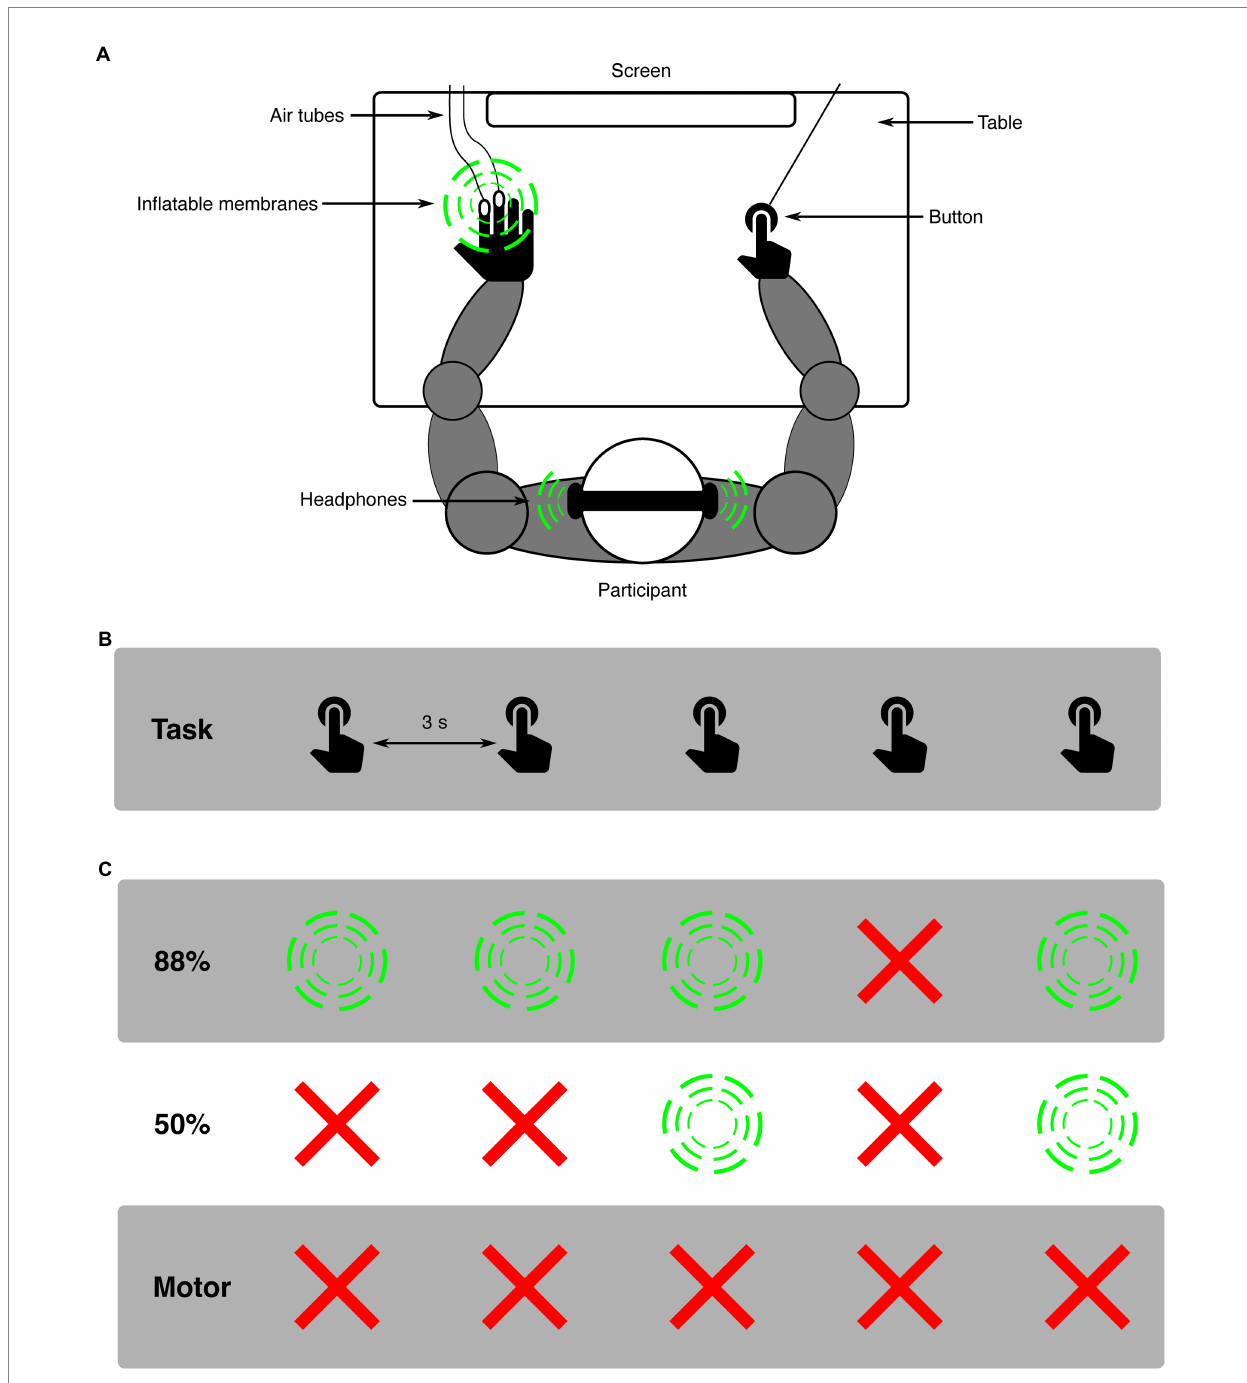
FIGURE 1 Schematic representation of the experimental design. (A) shows the experimental set-up: a participant sat in front of a screen with both arms on a table. With the right hand a button was pressed, possibly resulting in a stimulus (indicated with green circles). The same stimulus modality was always presented in one experimental block, either auditory or somatosensory. Auditory stimuli were presented using headphones. Somatosensory stimuli were applied by a puff of air traveling through air tubes and inflating a membrane on the left middle- and index-finger s . (B) depicts the task over time, where participants aimed to press a button every 3,000 ms. (C) shows examples of the effects of the button presses for all three conditions (green circles are stimulus presentations, red crosses are omissions). In the 88%-condition, there was an 88% chance of a button press resulting in a